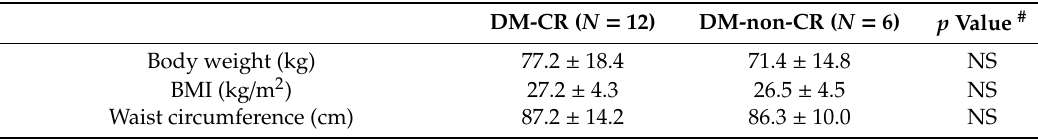
Table 2. Characteristics of patients with obesity and type 2 diabetes mellitus 1 year after sleeve gastrectomy between the complete remitters of diabetes mellitus (DM-CR) and non-complete remitters of diabetes mellitus (DM-non-CR).